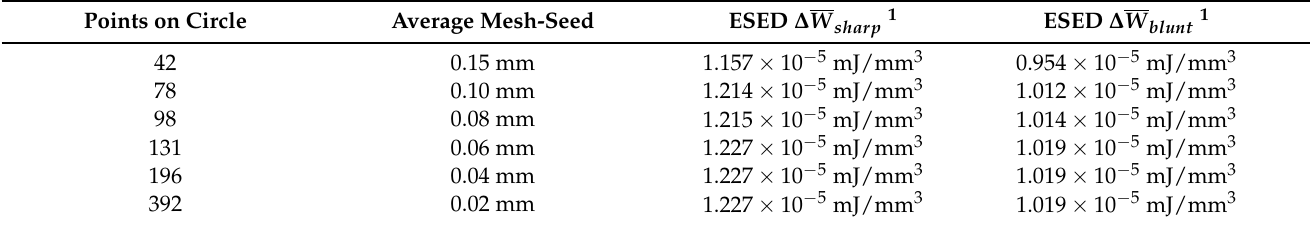
Table 9. Effect of mesh-seed on evaluated ESED for sharp and blunt notch assessment of circular hole-in-plate